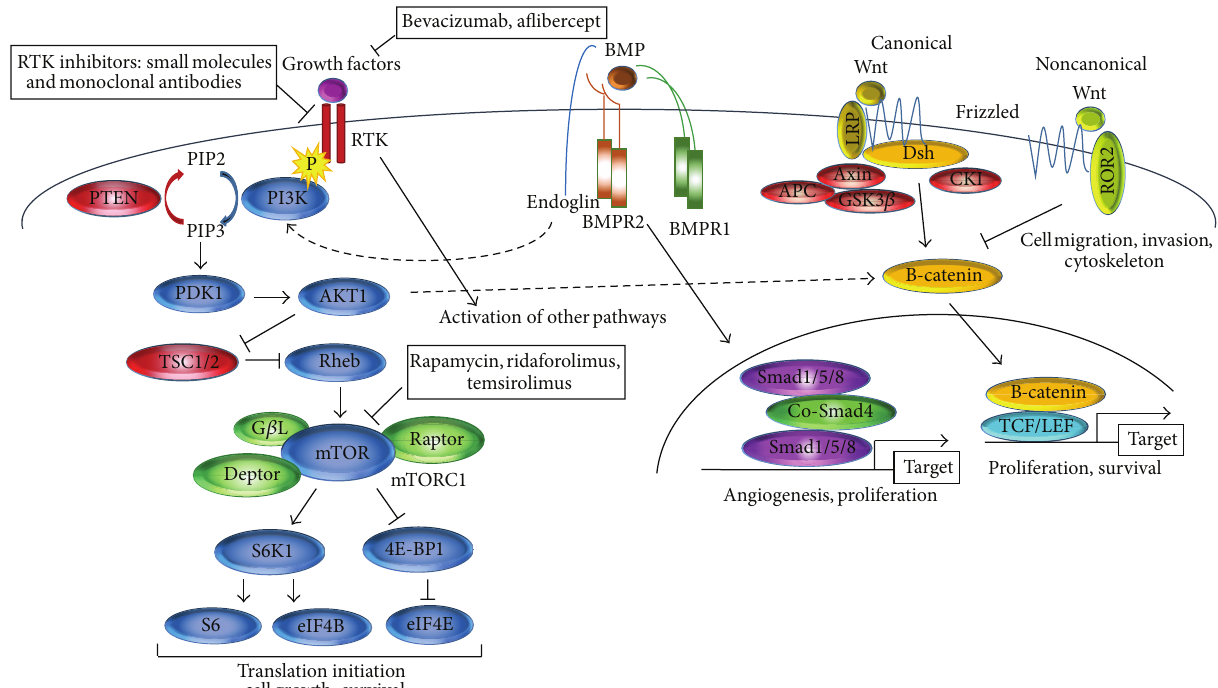
Figure 1: Left: the PI3K/AKT/mTOR pathway is mainly activated by nutrients (not shown) and growth factors, binding to receptor tyrosine kinases and activating PI3K. As PIP2 (phosphatidylinositol 4,5-bisphosphate) is converted to PIP3 (phosphatidylinositol 3,4,5-trisphosphate), PDK1 (pyruvate dehydrogenase kinase, isozyme 1) phosphorylates AKT1 (v-akt murine thymoma viral oncogene homolog 1) upon PIP3- mediated recruitment to the plasma membrane. AKT1 inhibits TSC1/2 (tuberous sclerosis 1/2), relieving the inhibition of Rheb (Ras homolog enriched in brain), which activates mTOR. The recruitment of Raptor (regulatory associated protein of MTOR, complex 1), Deptor (DEP domain containing MTOR-interacting protein), and G 𝛽 L (mLST8; G protein beta subunit-like MTOR associated protein, LST8 homolog) gives rise to the mTOR complex 1 (mTORC1). Upon activation of S6K1 (ribosomal protein S6 kinase 1) and inhibition of 4EBP-1 (EIF4EBP1; eukaryotic translation initiation factor 4E binding protein 1), protein translation is stimulated by activation of ribosomal protein S6 and eIF4B andE(eukaryotictranslationinitiationfactor4BandE).Additionally,AKT1activates 𝛽 -cateninsignaling.Middle:BMP(bonemorphogenetic protein) signaling is modulated through binding of BMPs to BMPR1 and BMPR2 (bone morphogenetic protein receptor type I/II) and the coreceptor endoglin, activating Smad1/5/8 and leading to transcription of target genes involved in angiogenesis and proliferation. Endoglin may also activate PI3K/AKT signaling. Right: canonical Wnt signaling is activated by binding of Wnt to the Frizzled receptor and the LRP (low-density lipoprotein receptor-related protein) coreceptor. Upon recruitment of Dsh (dishevelled) and Axin to the plasma membrane, the 𝛽 -catenindestructioncomplex,whichcontainsAxin,APC(adenomatosispolyposiscoli),GSK3(glycogensynthasekinase3),andCKI(casein kinase 1), is inactivated, leading to 𝛽 -catenin accumulation and transcription of target genes after association with TCF/LEF (transcription factor/lymphoid enhancer-binding factor). Noncanonical signaling plays a role in cell migration, invasion, and cytoskeleton arrangement and is mediated through binding of Wnt to Frizzled and other coreceptors such as ROR2 (receptor tyrosine kinase-like orphan receptor 2) or without